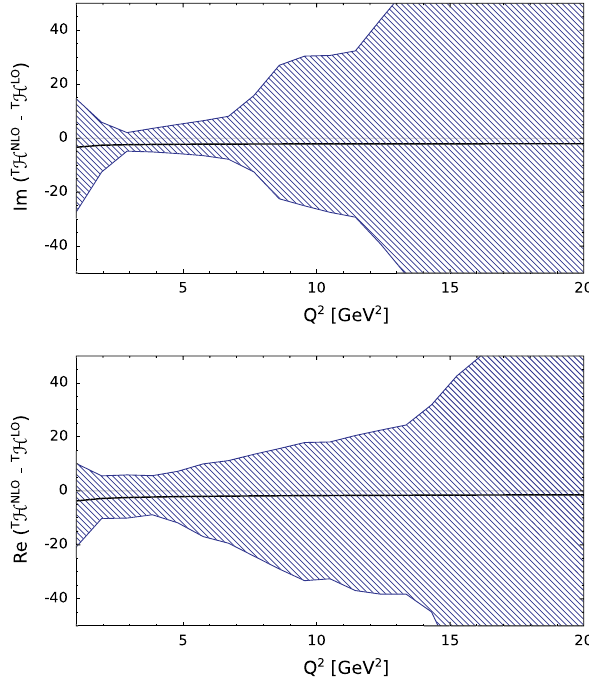
Fig. 3 Imaginary (up) and real (down) part of the NLO contribution to the spacelike-to-timelike relation for CFF H for ξ = 0 . 1 and t = − 0 . 3 GeV 2 as a function of Q 2 . For the further description see the caption of Fig.